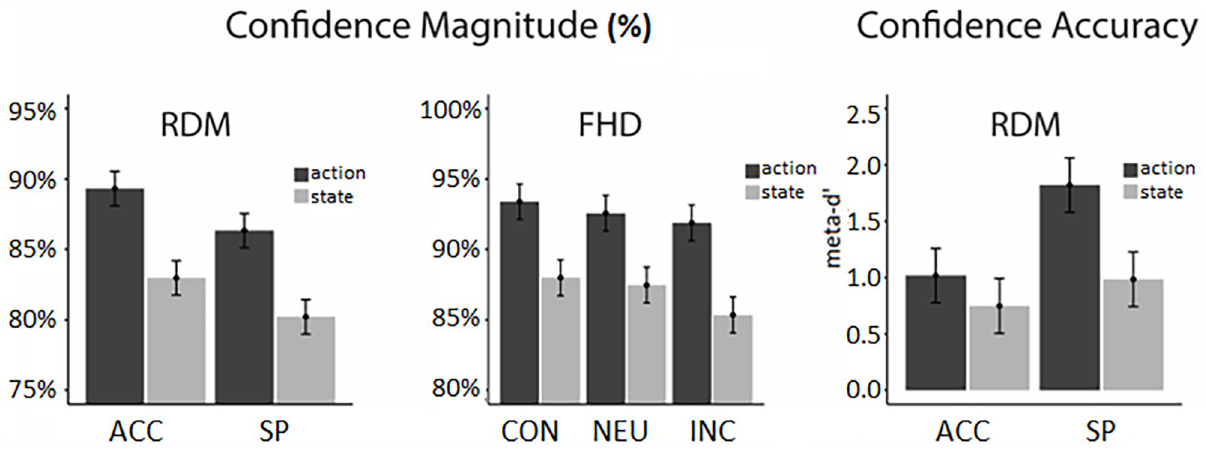
Fig 2. Significant group differences in confidence magnitude and accuracy across the two tasks (RDM: Random dot motion; FHD: Face/house discrimination). ACC and SP refer to the accuracy emphasis and speed emphasis conditions in the RDM task, respectively. CON, NEU and INC refer to the congruent , neutral and incongruent conditions in the FHD task, respectively. Error bars represent standard errors across participants.